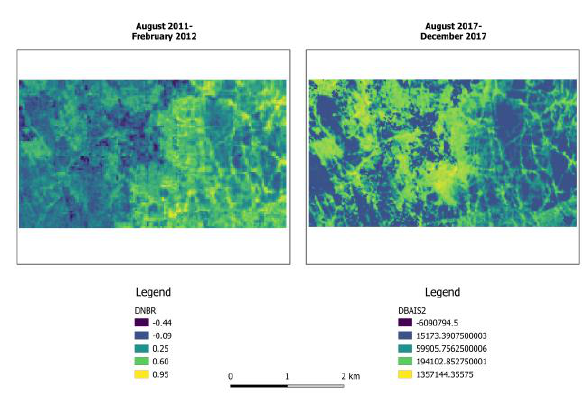
Figure 3. Difference between NBR and BAIS2 indexes.